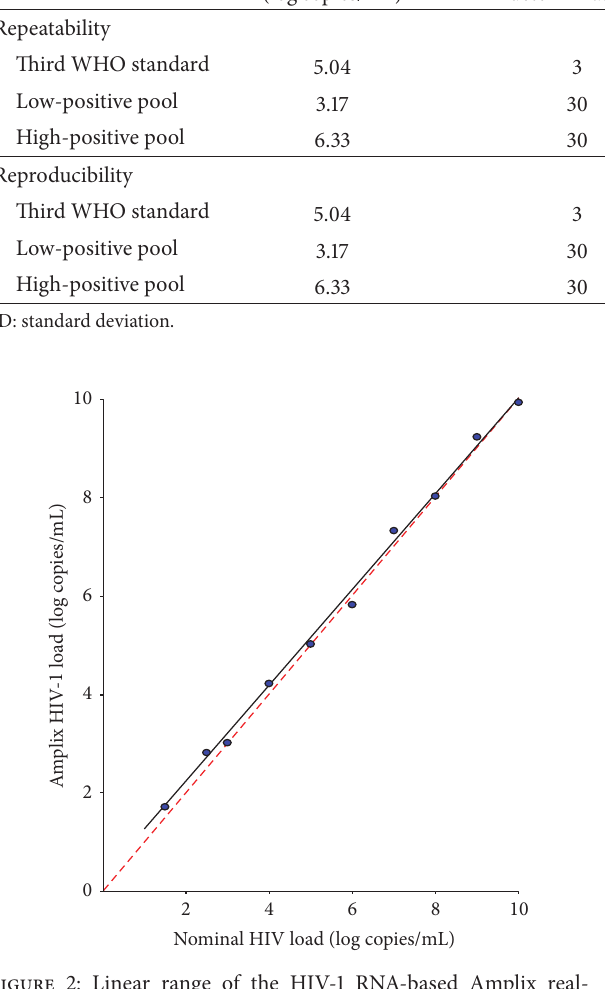
Figure 2: Linear range of the HIV-1 RNA-based Amplix real- time PCR assay. Viral HIV-1 RNA levels were measured in HIV- seronegative plasma samples that were spiked with HIV-1 group M subtype B viral stock (at 10,001,789 copies/mL) at final con- centrations of 25, 50, 100, 500, 5000, 100,000, 500,000, 2,000,000, 5,000,000, and 10,000,000 copies/mL. Slope and Y-intercept values for the resultant trend line were 0.980 (95% CI, [0.934–1.026]) and 0.253, respectively, as determined by unweighted linear regression ( 𝑟 2 = 0.981). Each sample was assayed in duplicate. The diagonal dotted line represents the ideal line (no bias). The full line represents the regression line of the distribution ( 𝑛 = 10